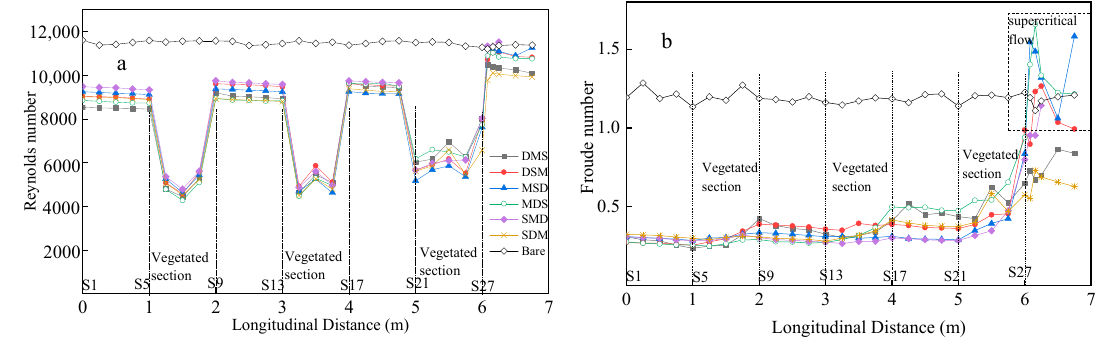
Figure 7. Variations in the ( a ) Reynolds number and ( b ) the Froude number in the longitudinal direction.